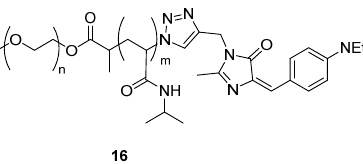
Figure 16. GFPc analogues linked to copolymer [30].